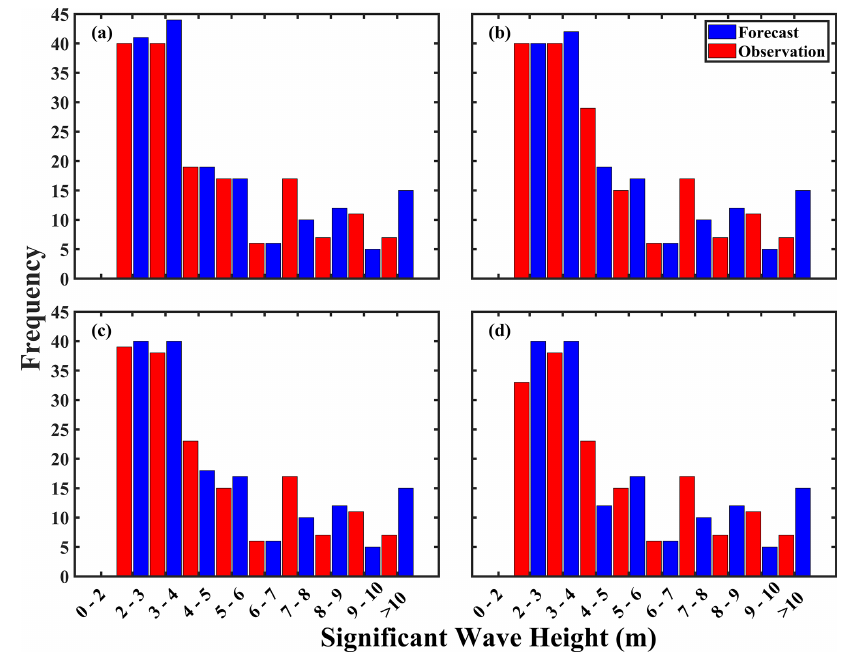
Figure 9. Same as Fig. 7, but for Hurricane Igor (2010). Results for the 9h forecast are presented in Fig. S4.